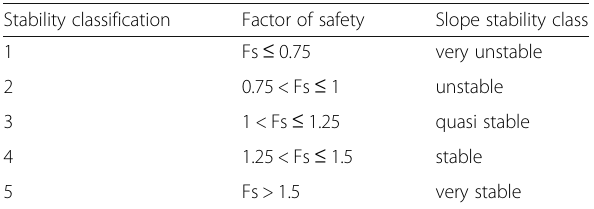
Table 5 Classifications of slope stability and instability based on Ray and De Smedt (2009) and Teixeira et al. (2015) Stability classification